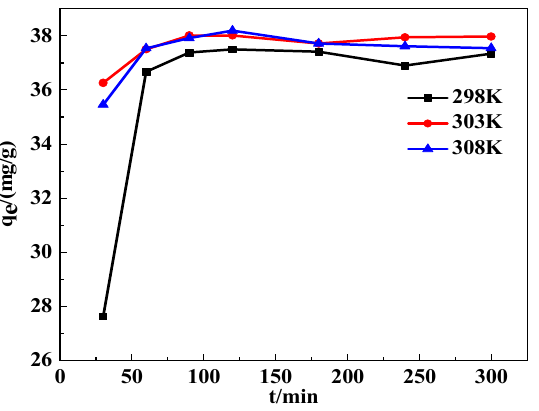
Figure 13. The effect of time on adsorption capacity at different temperatures. At different temperatures, the adsorption capacity and adsorption removal rate of MG increased with the increase of adsorption time. The adsorption capacity gradually